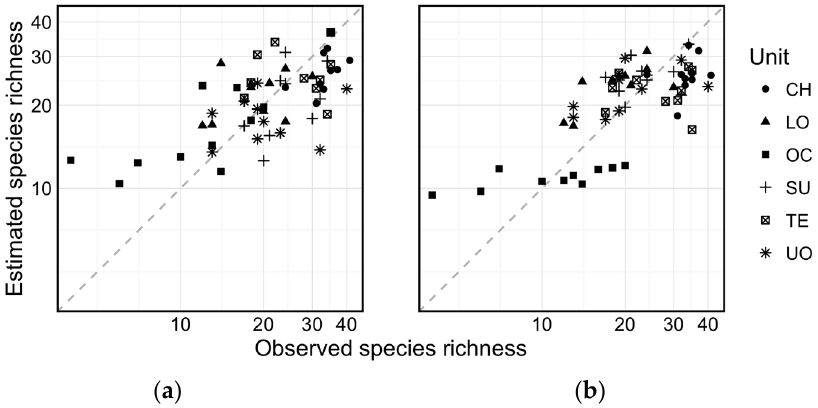
Figure 2. Observed species richness vs. species richness estimated by the best descriptive models based on ( a ) Google Earth and ( b ) SPOT image surface data. Unit refers to the geomorphological units in the study site.